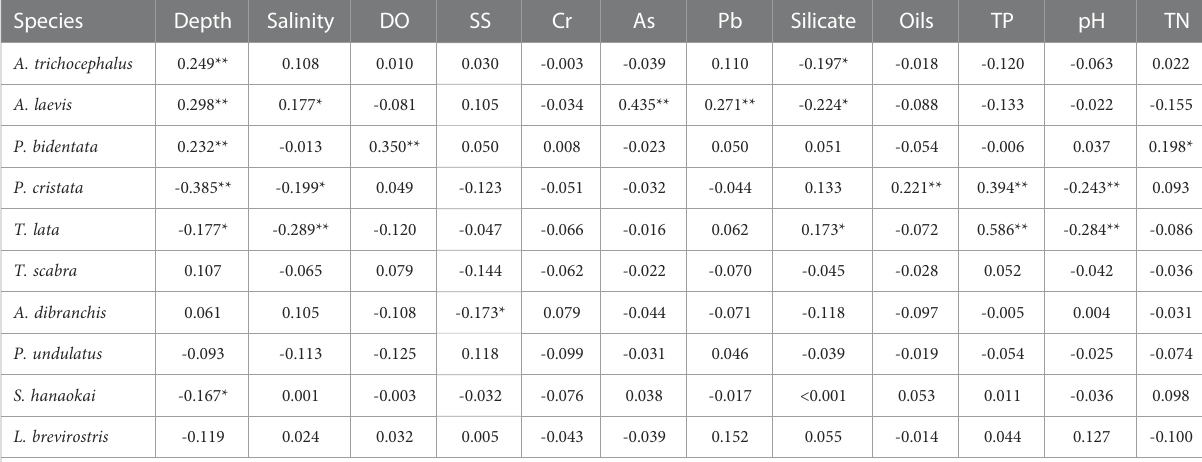
TABLE 5 Correlation analysis between biomass of ten species benthic macrofauna and water environmental factors in subtidal zone near the Daya Bay Nuclear Power Plant.